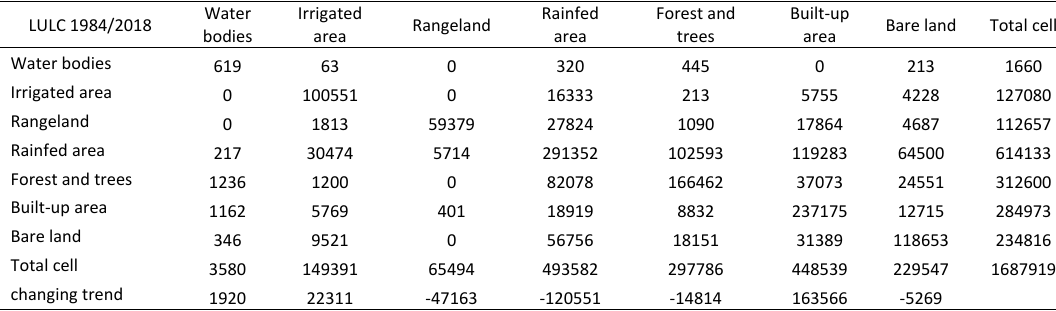
Table 6h: Transition area of each class for 1984-2018 (total round)